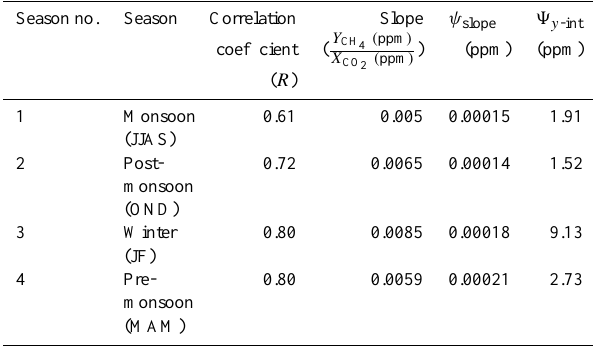
Table 2. Statistical correlation between CO 2 and CH 4 . Season